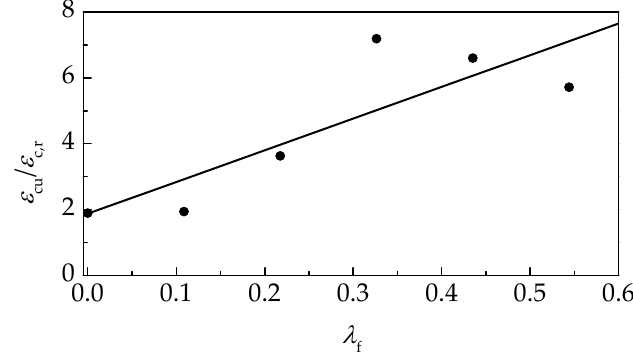
Figure 12. Change of ε cu / ε c,r with λ f.